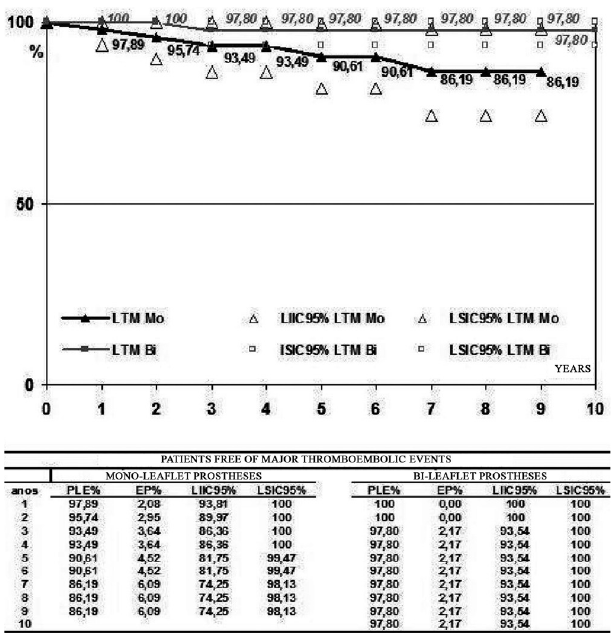
Fig. 4 - Curves and actuarial data showing the percentage of patients free of minor thromboembolic events mTE (ordinate) with time-years ( abscissa) for both types of prostheses studied. Mo = Mono-leaflet prosthesis; Bi = Bi-leaflet prosthesis; SE = standard error range; LLCI95% = lower limit of 95% Confidence Interval and ULCI95 % = Upper Limit of 95% Confidence Interval